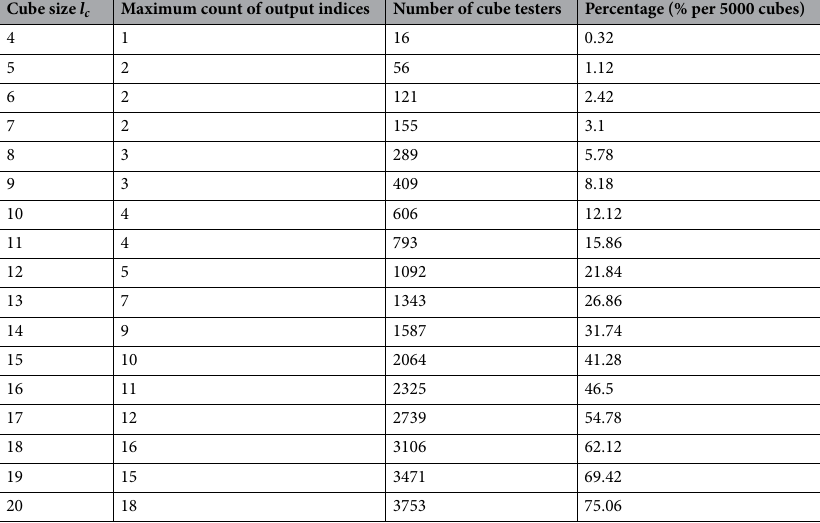
Table 4. Summary of the results of cube testers found using DA1.